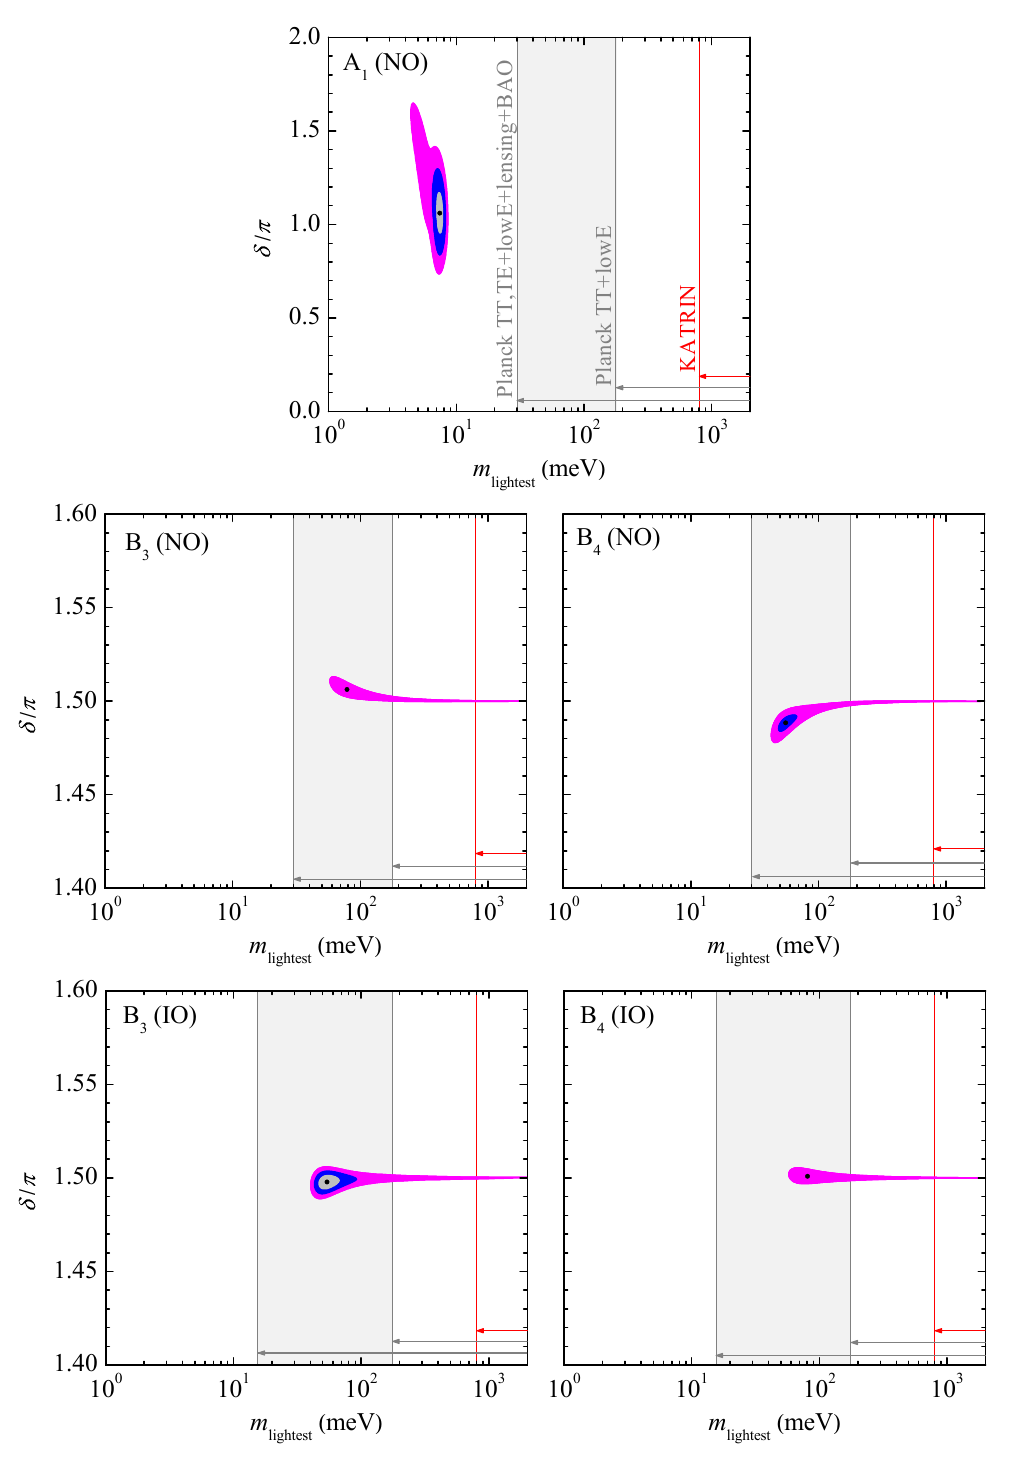
Figure 4 . Allowed regions in the plane ( m lightest , δ ) for NO (top and middle plots) and IO (bottom plots). The colour scheme is the same as in figure 3. The vertical red line corresponds to the upper limit for m extracted from the KATRIN bound on m lightest the m upper-limit interval obtained from the Planck cosmological bounds on P lightest